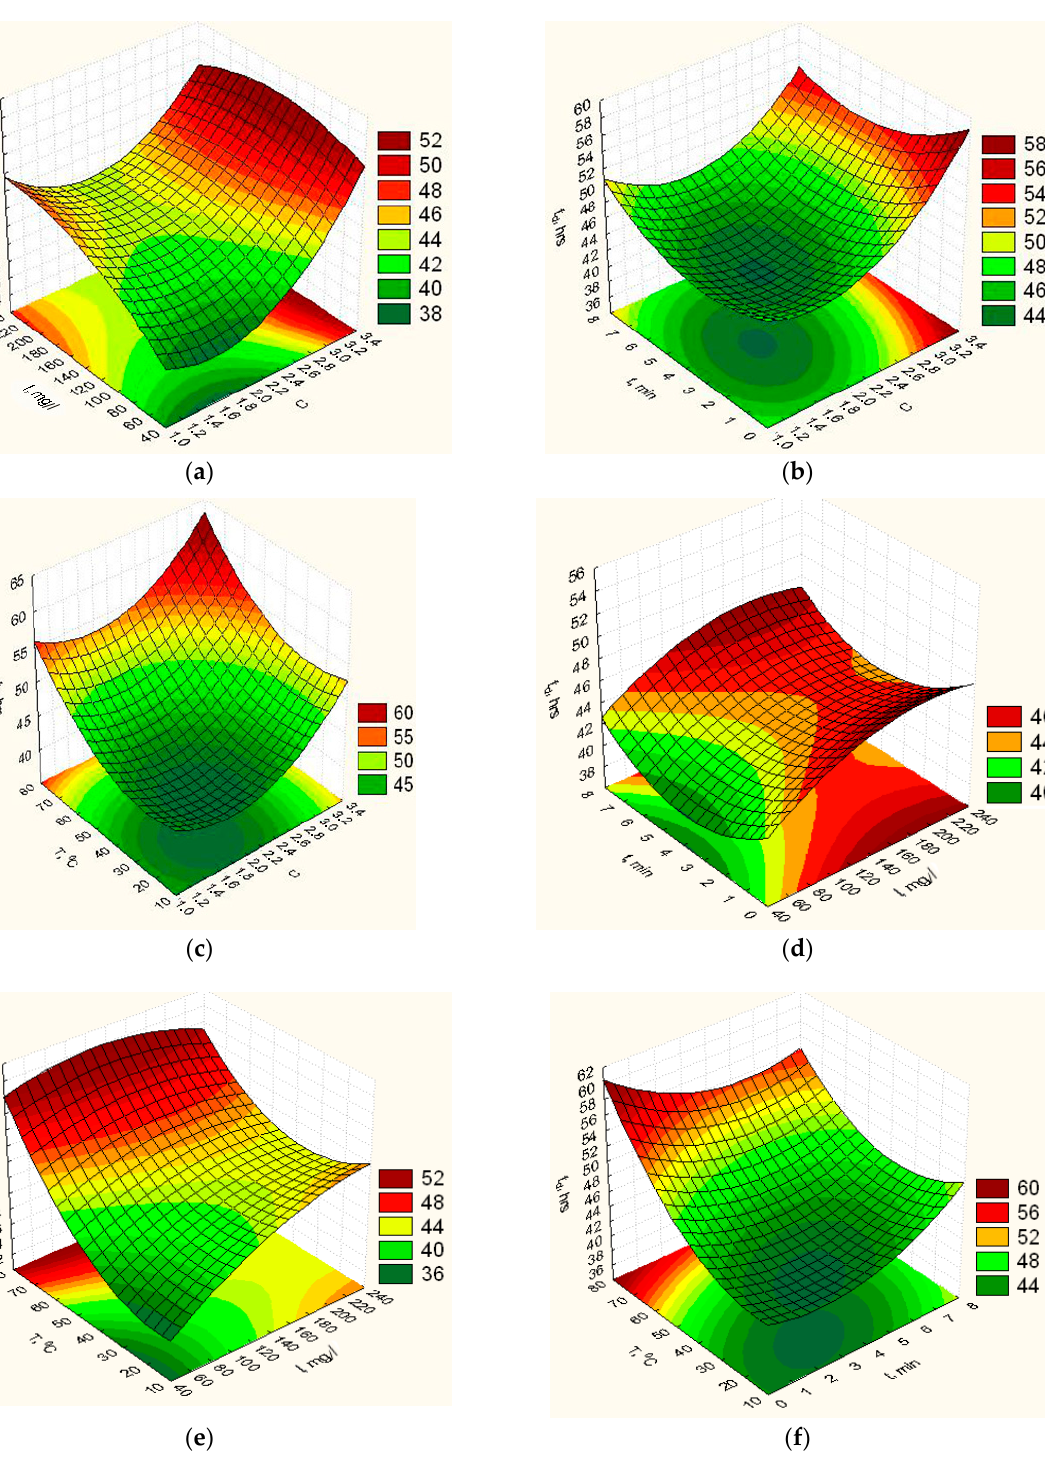
Figure 3. Response surfaces of the dependence of the degradation time of the film on the composition and technological parameters of its manufacture: ( a )— С , І , t = 4 min, T = 46 °C; ( b )— С , І = 140 mg/L, t , T = 46 °C; ( c )— С , І = 140 mg/L, t = 4 min, T ; ( d )— С = 2.2, І , t , T = 46 ° C; ( e )— С = 2.2, І , t = 4 min, T ; ( f )— С = 2.2, І = 140 mg/L, t , T.